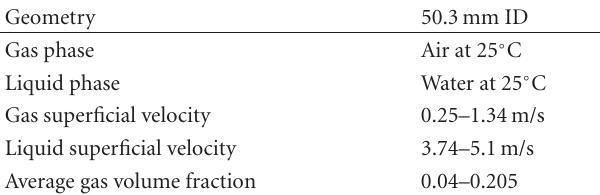
Table 2: Operating